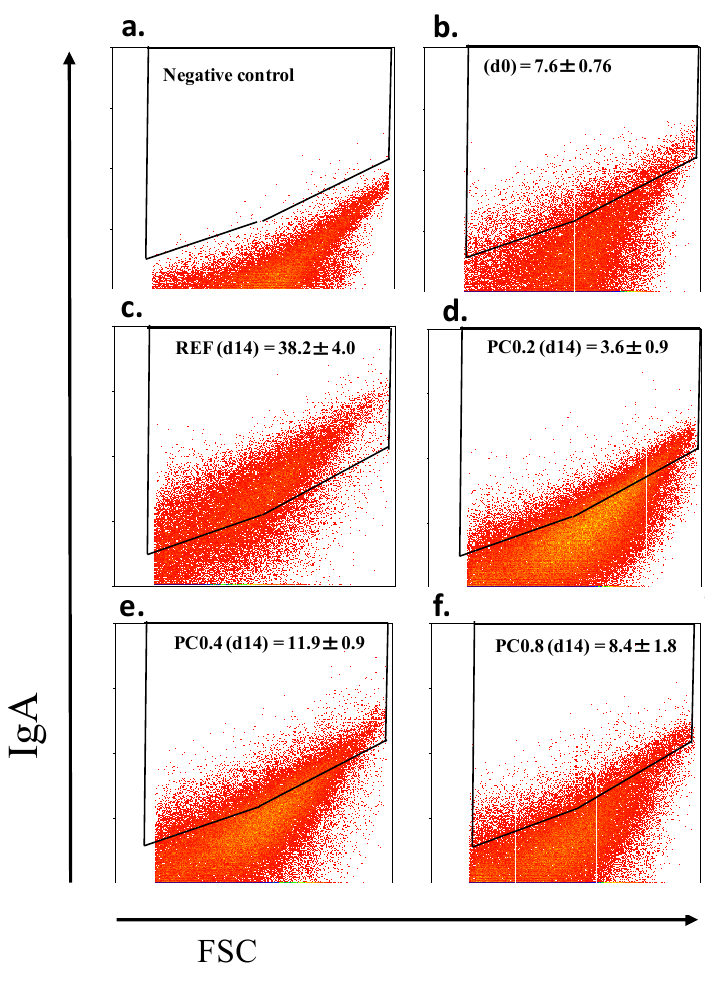
Figure 5. Effects of cocoa polyphenol-enriched diets on percentage of fecal bacteria coated with IgA before and after 2 weeks of nutritional intervention. Biparametric cytogram corresponding to a negative fecal control ( a ). It combines morphological parameters of the bacterial population (FSC/SSC) and fluorescence for IgA-fluorescein isothiocyanate (FITC) which allow the threshold for the positive region to be established. Cytogram, which represents the percentage of IgA-coating bacteria at baseline for all groups ( b ). Cytograms for IgA-coating bacteria detection for REF ( c ), PC0.2 ( d ), PC0.4 ( e ) and PC0.8 ( f ) groups at the end of the study. Results are expressed as mean ± SEM ( n =